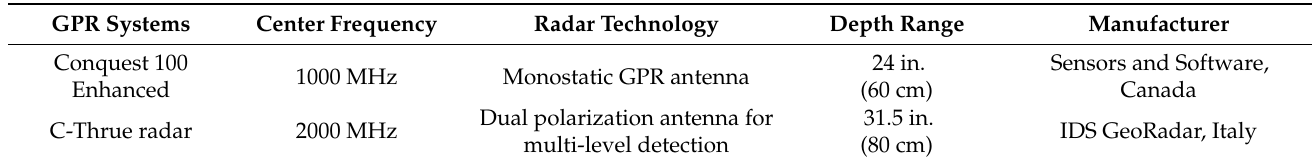
Table 3. Technical specifications of the GPR systems used